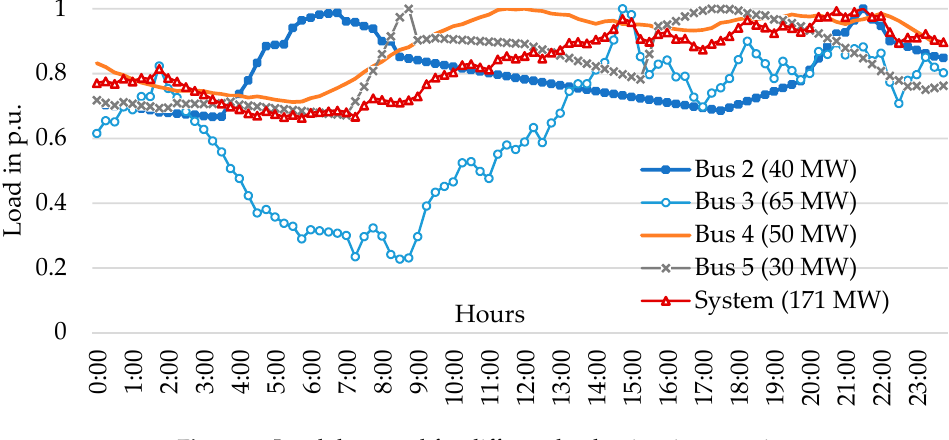
Figure 5. Load data used for different load points in per unit.